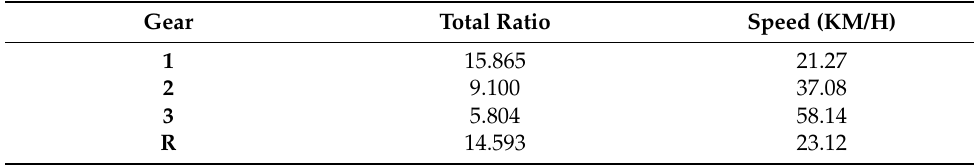
Table 2. Total ratio and maximum speed per gear.